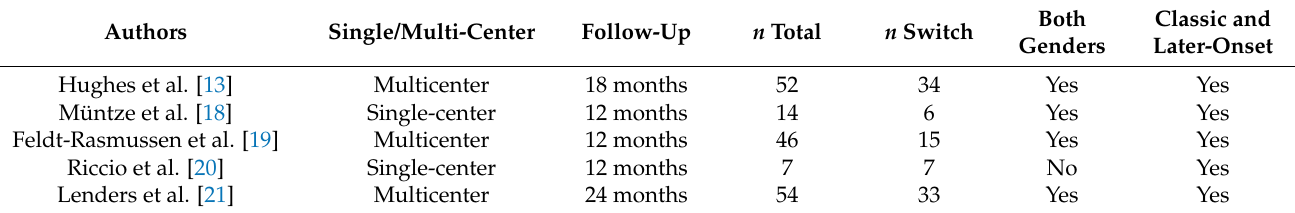
Table 1. Characteristics of the